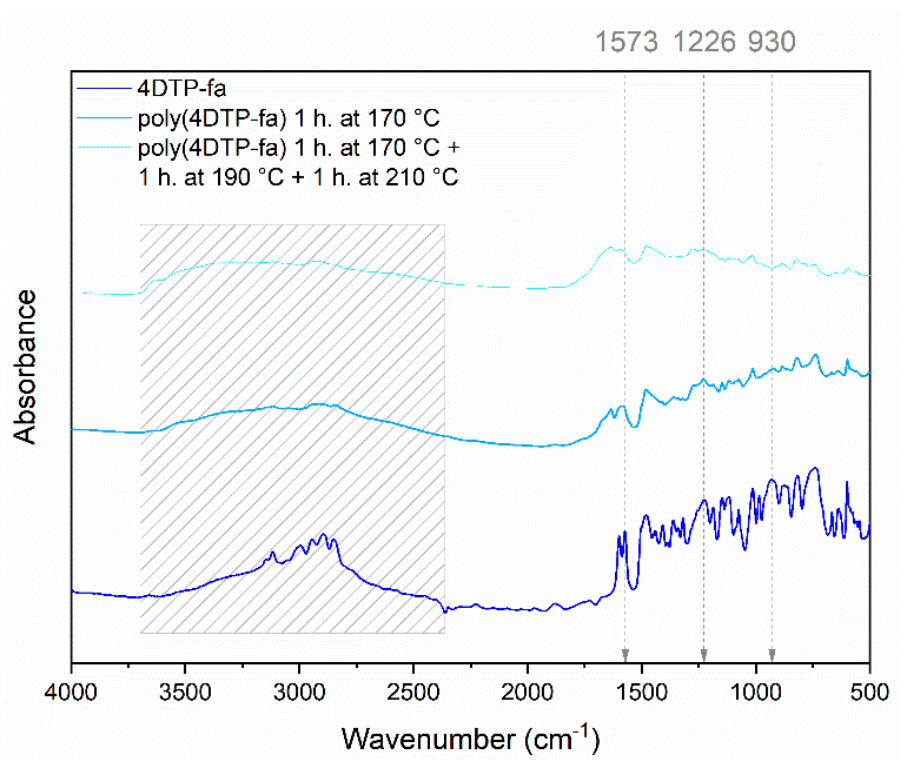
Figure A16. FTIR spectra of 4DTP-fa, poly(4DTP-fa) after curing at 170 °C for 1 h, and poly(4DTP-fa) after curing at 170 °C for 1h and post-curing at 190 °C for 1h and 210 °C for 1 h.